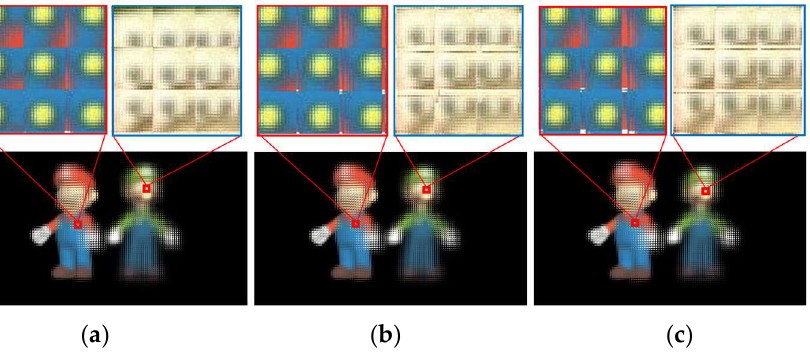
Figure 8. Comparisons of ( a ) Conventional EIA, ( b ) FEP-EIA with L = 450 mm, and ( c ) FEP-EIA with L = 250 mm. Table 2. Comparisons of the viewing angles.